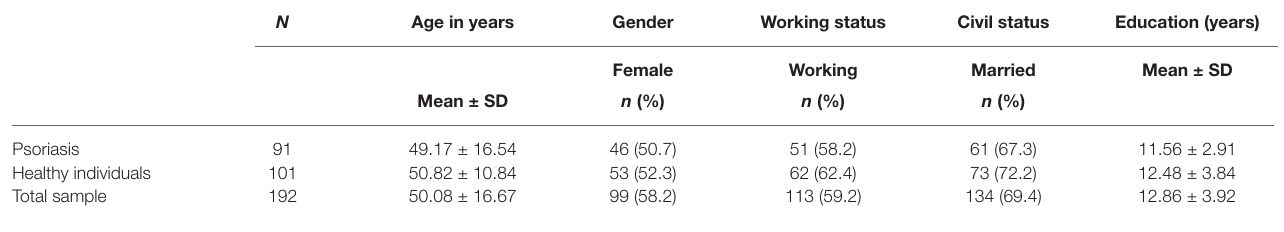
TABLE 2 | Participants